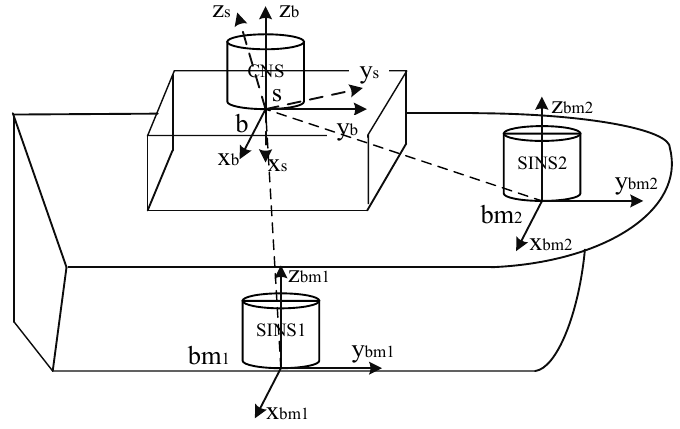
Figure 1. The composition of the initial alignment